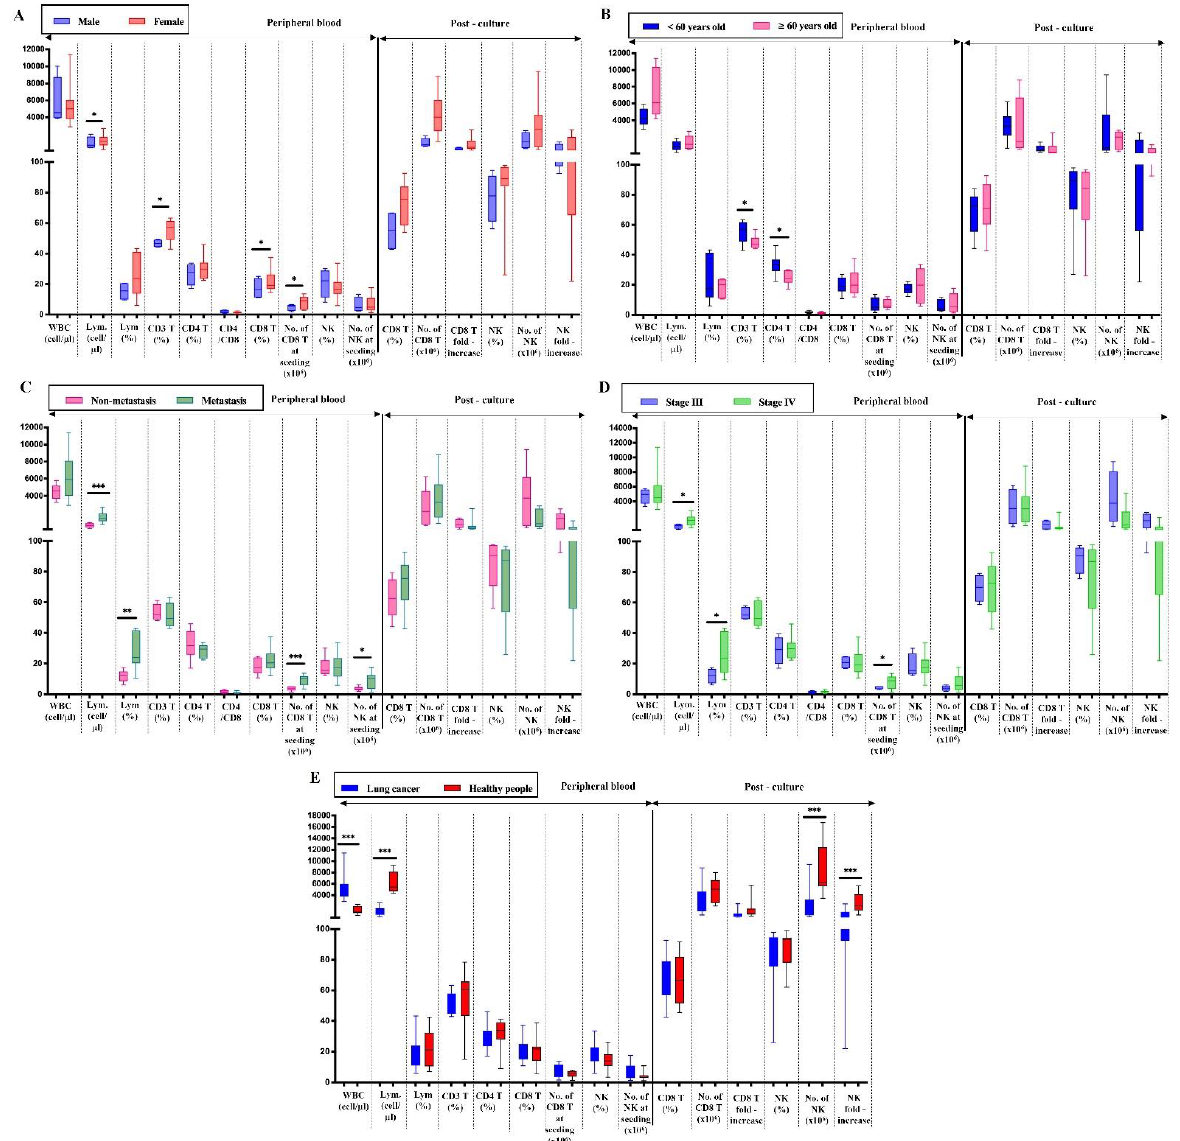
Figure 3 . The capacity of immune cell expansion by age, gender, metastasis state, and cancer stages, and between cancer patients and healthy people. The comparison of median values of PB indices and immune cell expansion ability by gender ( A ), age below and above 60 years old ( B ), metastasis state ( C ), and cancer stages III and IV ( D ), and cancer patients and healthy people ( E ). Significant differences were obtained by the Wilcoxon signed-rank test followed by the Bonferroni correction. Median values and interquartile ranges are shown in the graphs. Significance levels were set to p < 0.05 (*), p < 0.01 (**), and p < 0.001 (***). PB: Peripheral blood; Lym.: Lymphocytes. No.: